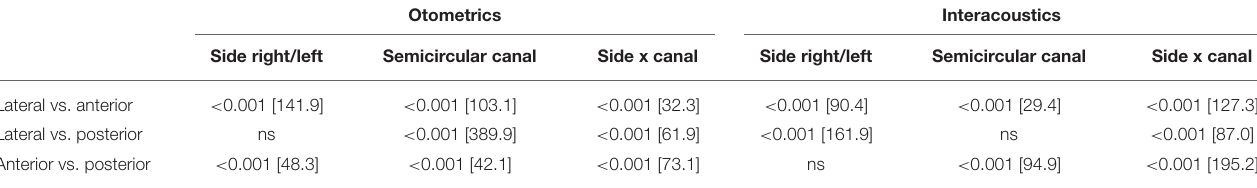
TABLE 2 | Repeated measures GLM ANOVA with main factors “stimulated side,” “semicircular canal,” and their factor interactions. Otometrics Interacoustics Side right/left Semicircular canal Side x canal Side right/left